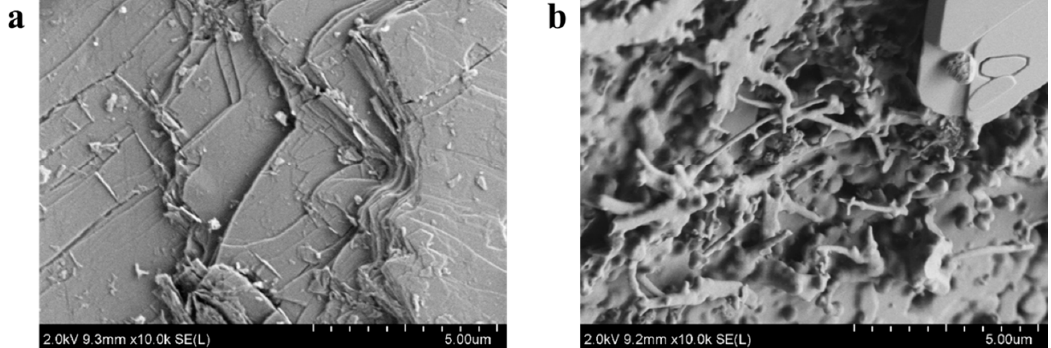
Figure 4. SEM diagram of ( a ) lepidolite concentrate powder and ( b ) leaching residue leached after 4 h.